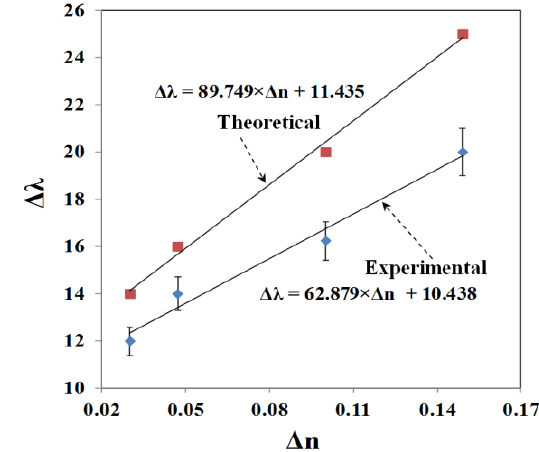
Figure 13. Measured and simulated variation of LSPR shift against the change in refractive